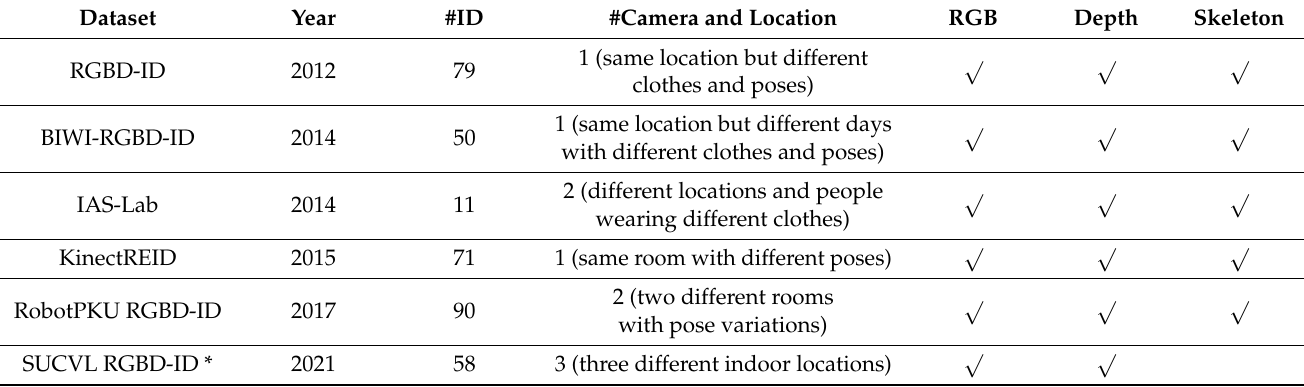
Figure 12. Sample images showing frontal, rear, and side views of an individual, with the camera installed at a horizontal viewpoint. Table 2. Shows summarized information about the multi-modal datasets. ‘*’ indicates the dataset is not publicly